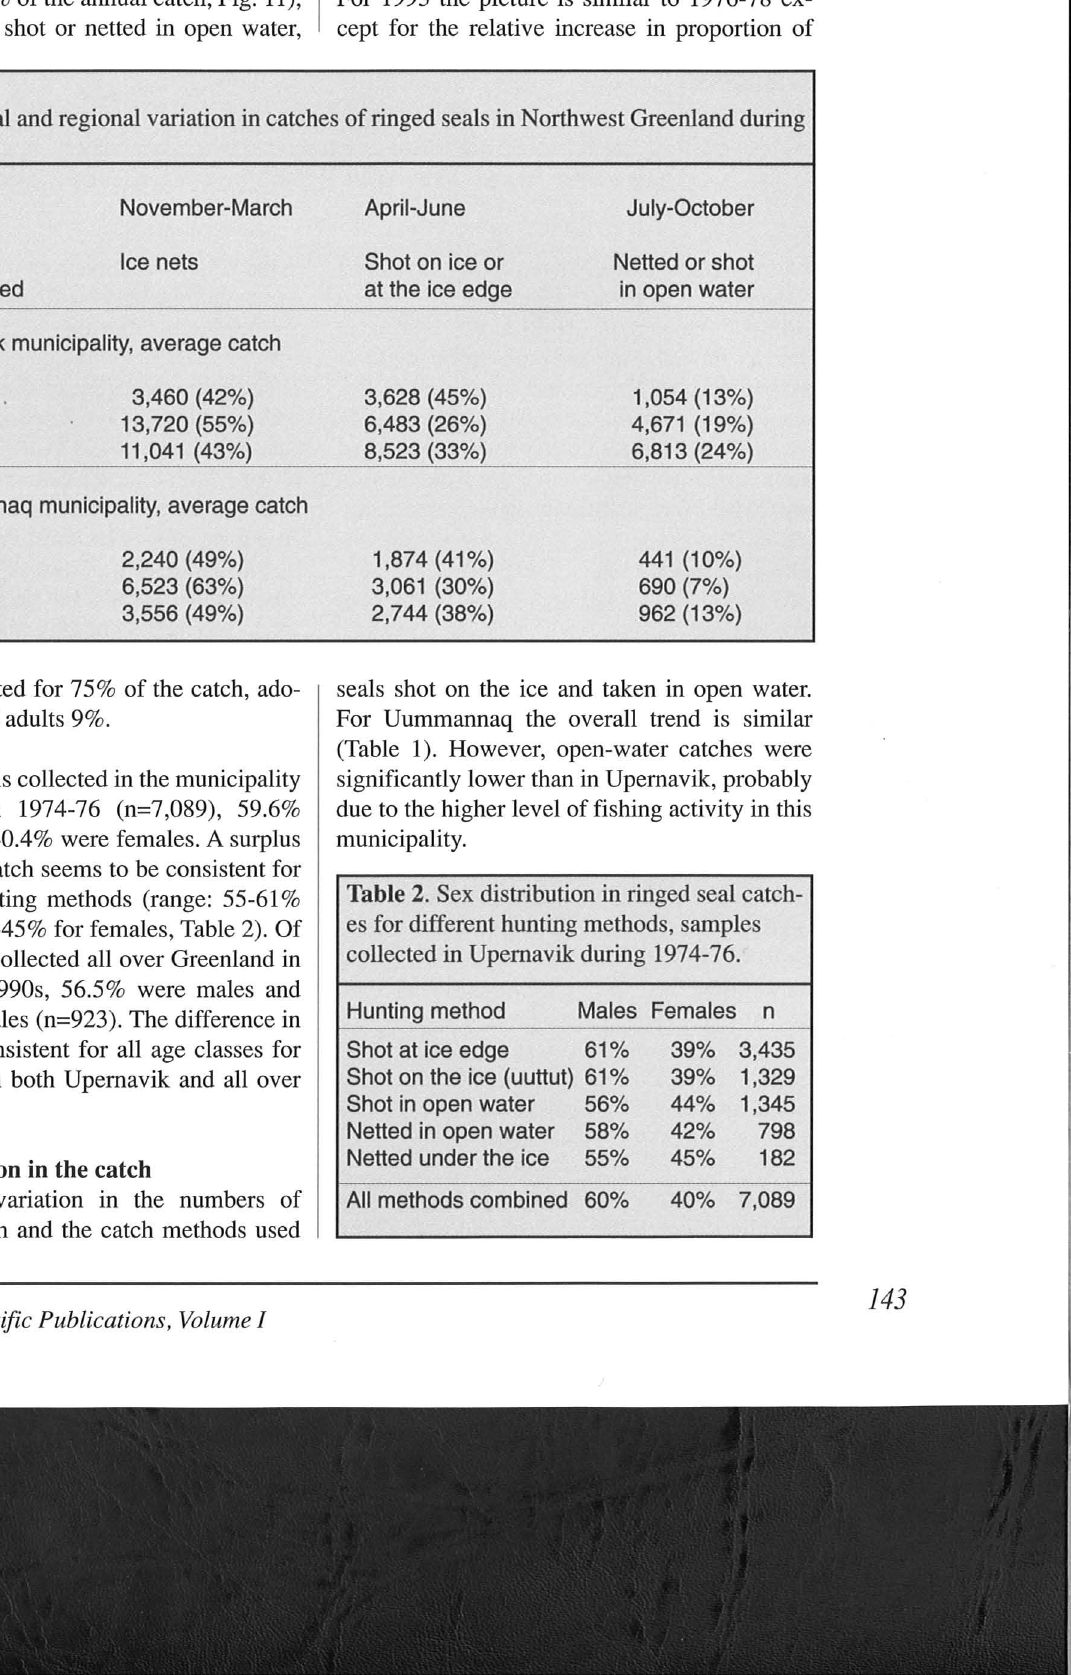
Table 1. Seasonal and regional variation in catches of ringed seals in Northwest Greenland during three periods.